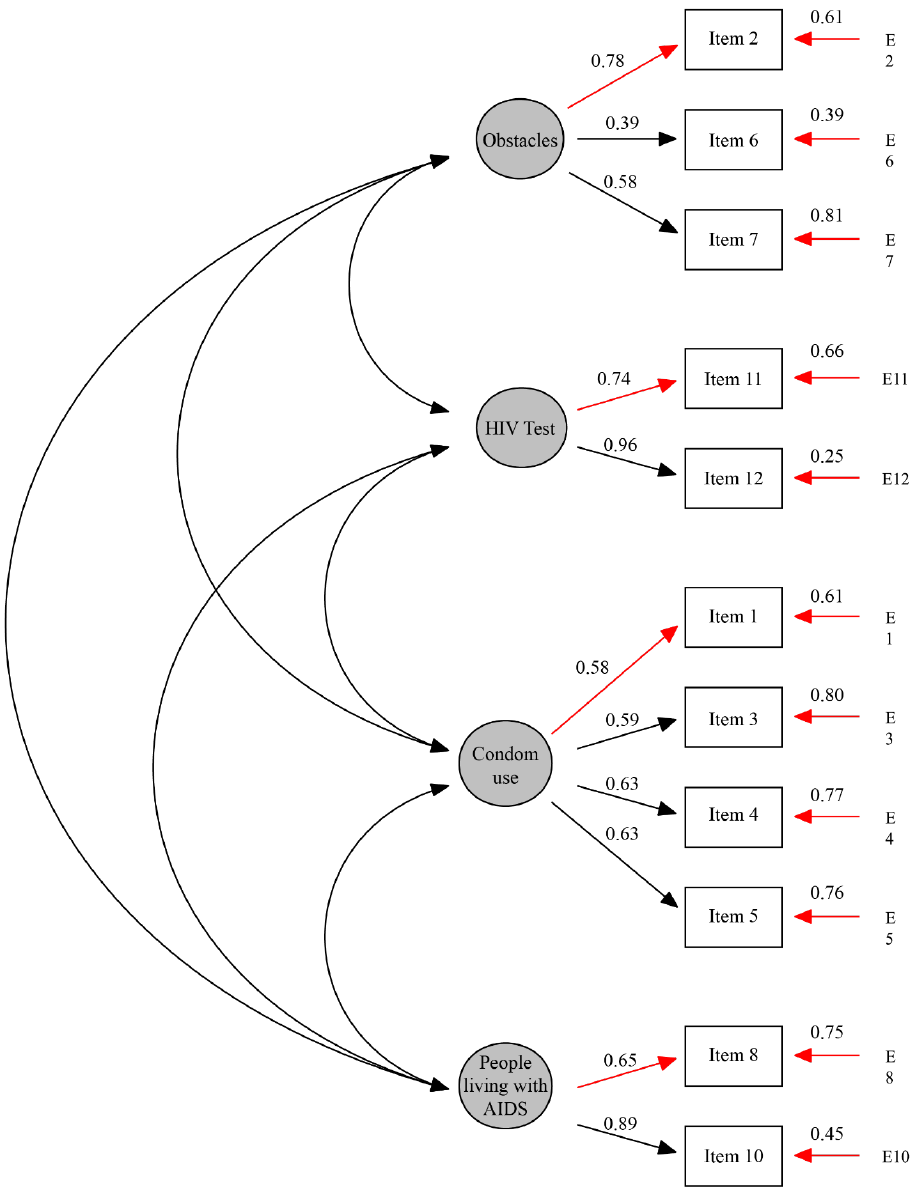
Figure 1. Flow chart of the model. Standardized